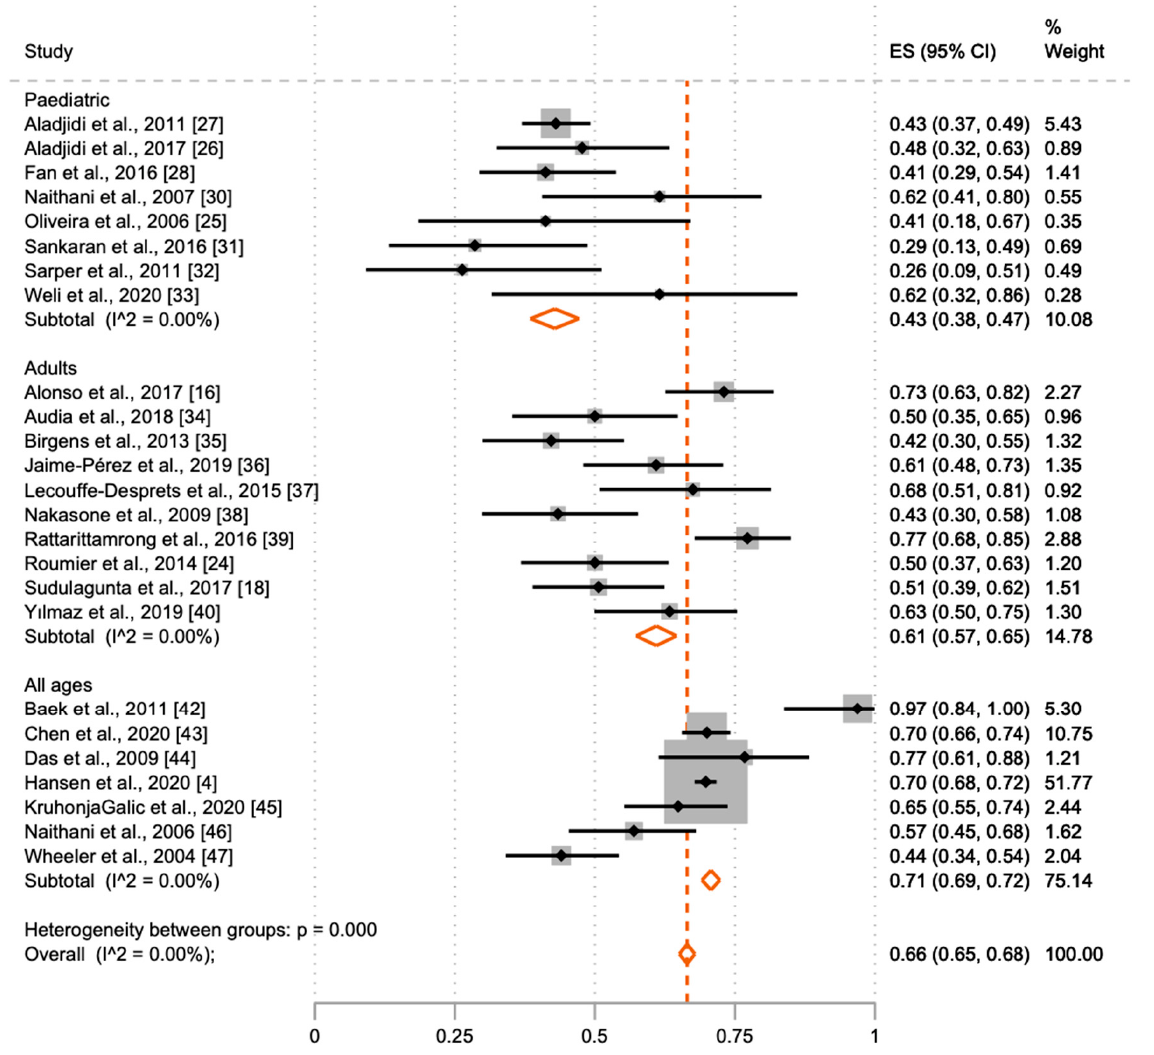
Figure 2. Meta-analysis of the proportion of females in patients with warm autoimmune haemolytic anaemia (wAIHA) with 95% CI and the weight of the included studies. Meta-analysis of the proportion of females with wAIHA by age-group in the studies, generation using the meta-prop procedure in Stata. I 2 = 0.0% represents a presumably very low heterogeneity in the included studies, as the 95% CI are overlapping. Each of the black (cid:4) -symbols represents the ES and 95% CI for one study. The orange ♦ -symbols are the pool effect estimates from subgroups and